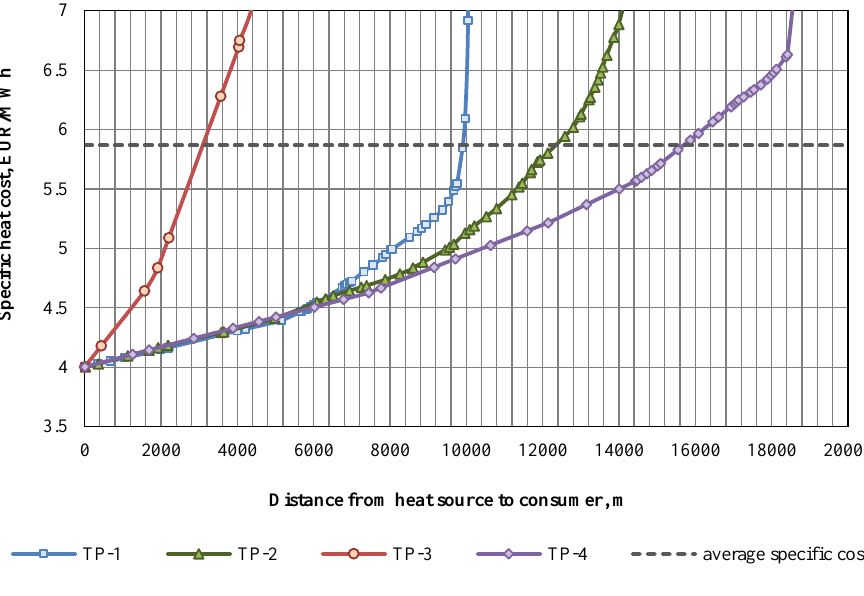
Fig. 3. Specific heat cost for the longest branches of transmission pipelines (TP) of the DHS of Irkutsk city on based NICHPP: crossing of line with average level (dashed line) corresponds to decision on EHSR.